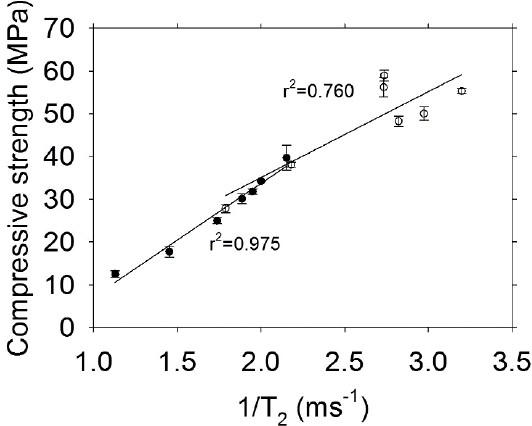
Figure 13. Transverse relaxation rate obtained with the Oxford Instruments Maran DRX- HF 12/50 system versus compressive w/c = 0.60, ○ Concrete w/c =